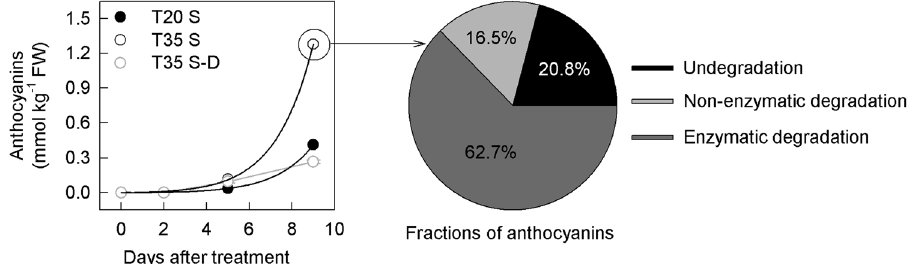
Figure 8. Panel A, concentrations of grossly synthesized anthocyanin in the peel of plum fruits treated at 20 °C and 35 °C for different time in the dark; Panel B, fractions of anthocyanins in 35 °C treated fruit peel at day